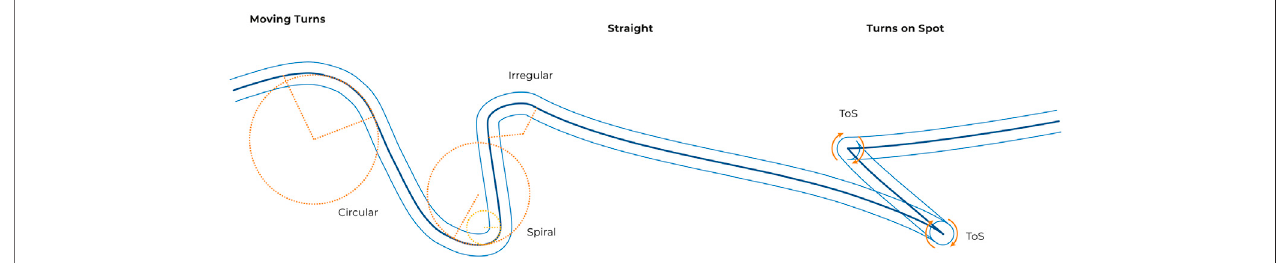
FIGURE 2 | Examples of classi fi ed segments: Moving windows were divided into straight sections, turns-on-the-spot and moving turns whereby the latter were further subclassi fi ed as regular, spiral or irregular turns based on their